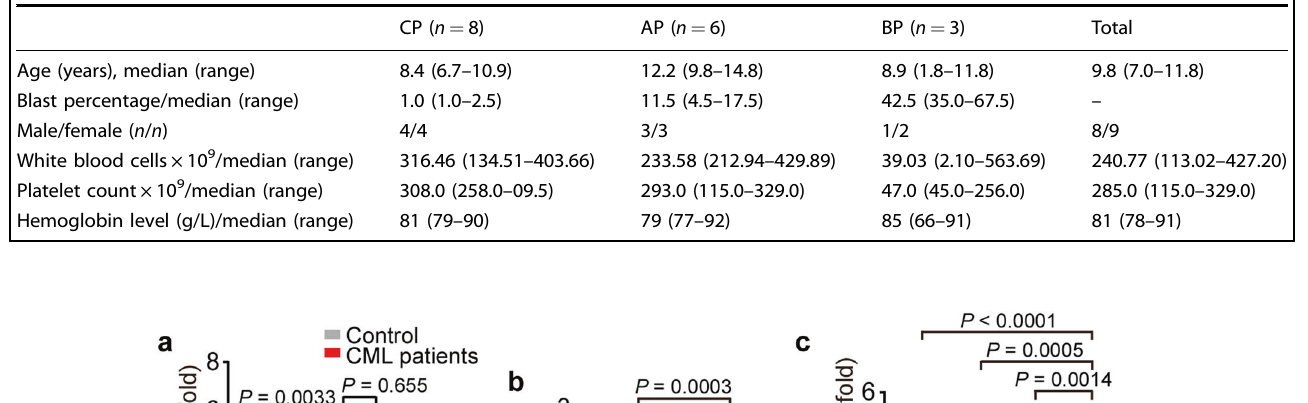
Table 1. Clinical characteristics of the